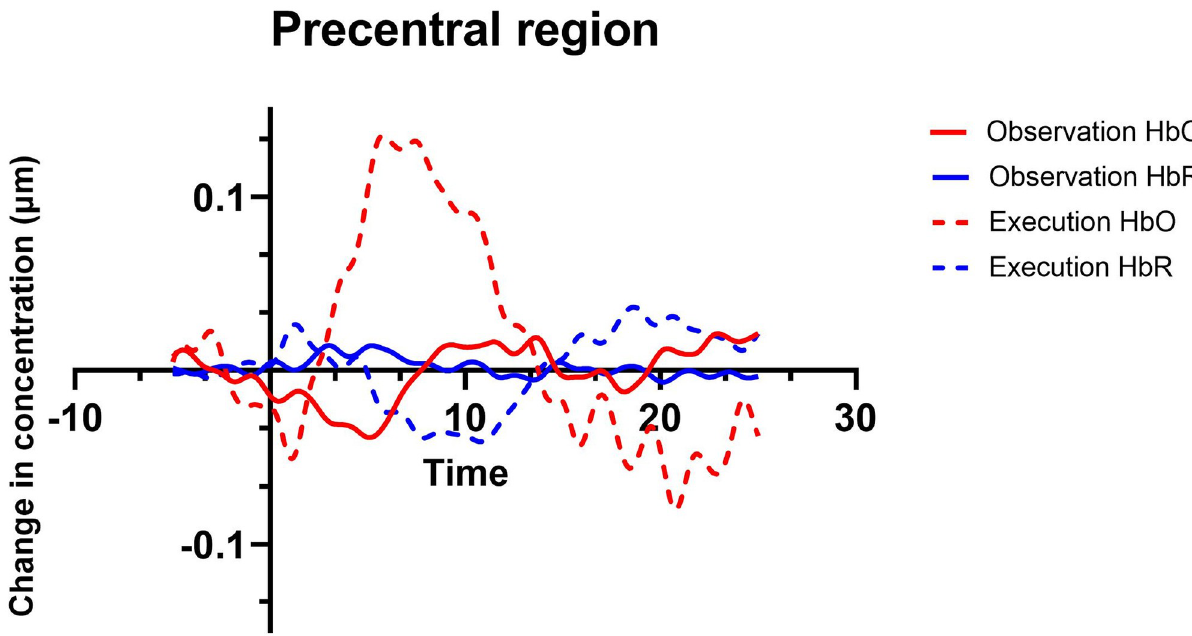
Fig 6. Hemodynamic response function for precentral region during execution and observation conditions.